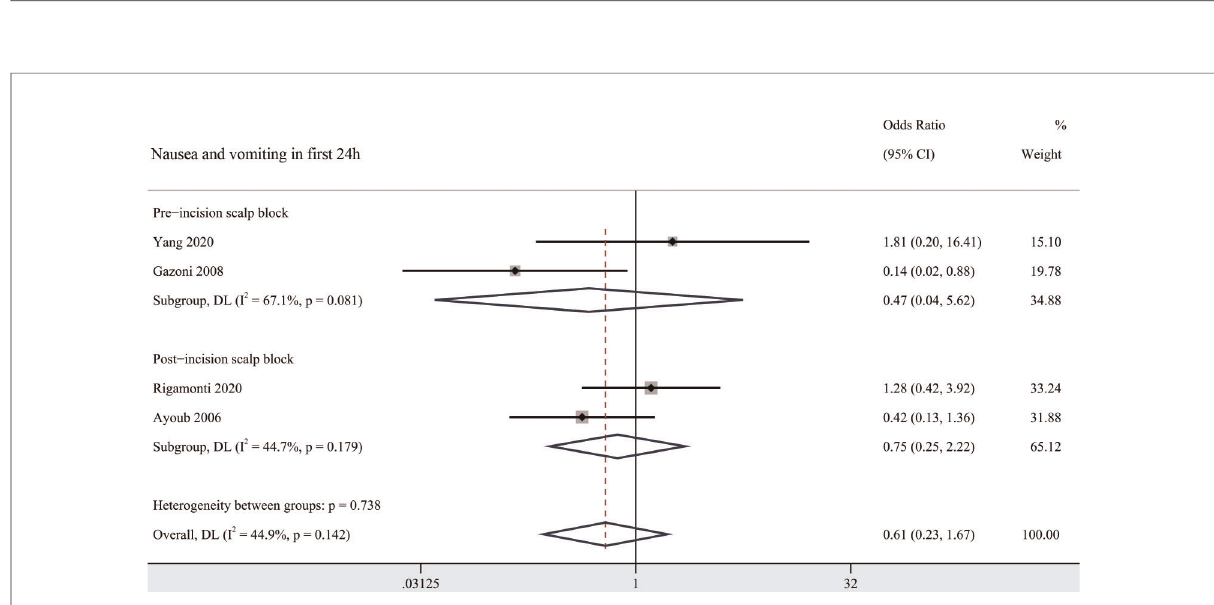
FIGURE 4 Forest plot summarizing meta-analysis of studies reporting nausea and vomiting in fi rst 24 h. Notes: The black solid rhombuses indicate the estimated odds ratio for each randomized controlled trial and the extending lines indicate the estimated 95% CI of odds ratio for each randomized controlled trial; The black hollow rhombuses indicate the estimated odds ratio (95% CI) for patients in each subgroup or all patients included; Weights are from a random-effects analysis. Abbreviation: SB, Scalp Block; NSB, non-Scalp Block; CI, con fi dence interval.